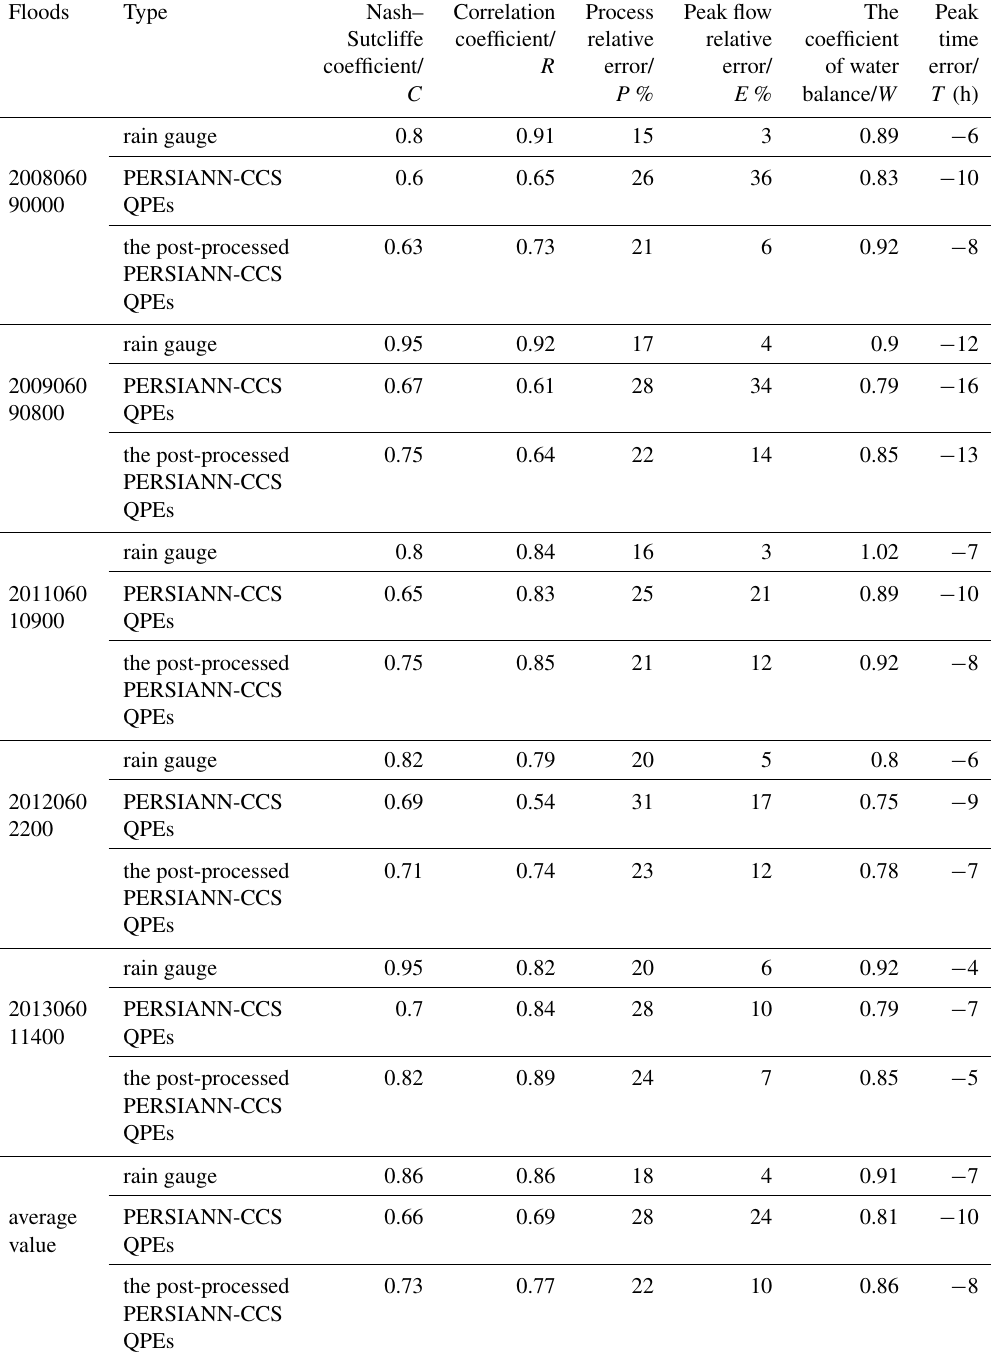
Table 7. Evaluation indices of simulated flood events using the initial PERSIANN-CCS QPEs and the post-processed values. Floods Type Nash– Correlation Process Peak flow The Peak Sutcliffe coefficient/ relative relative coefficient time coefficient/ R error/ error/ of water error/ C P % E % balance/ W T (h)